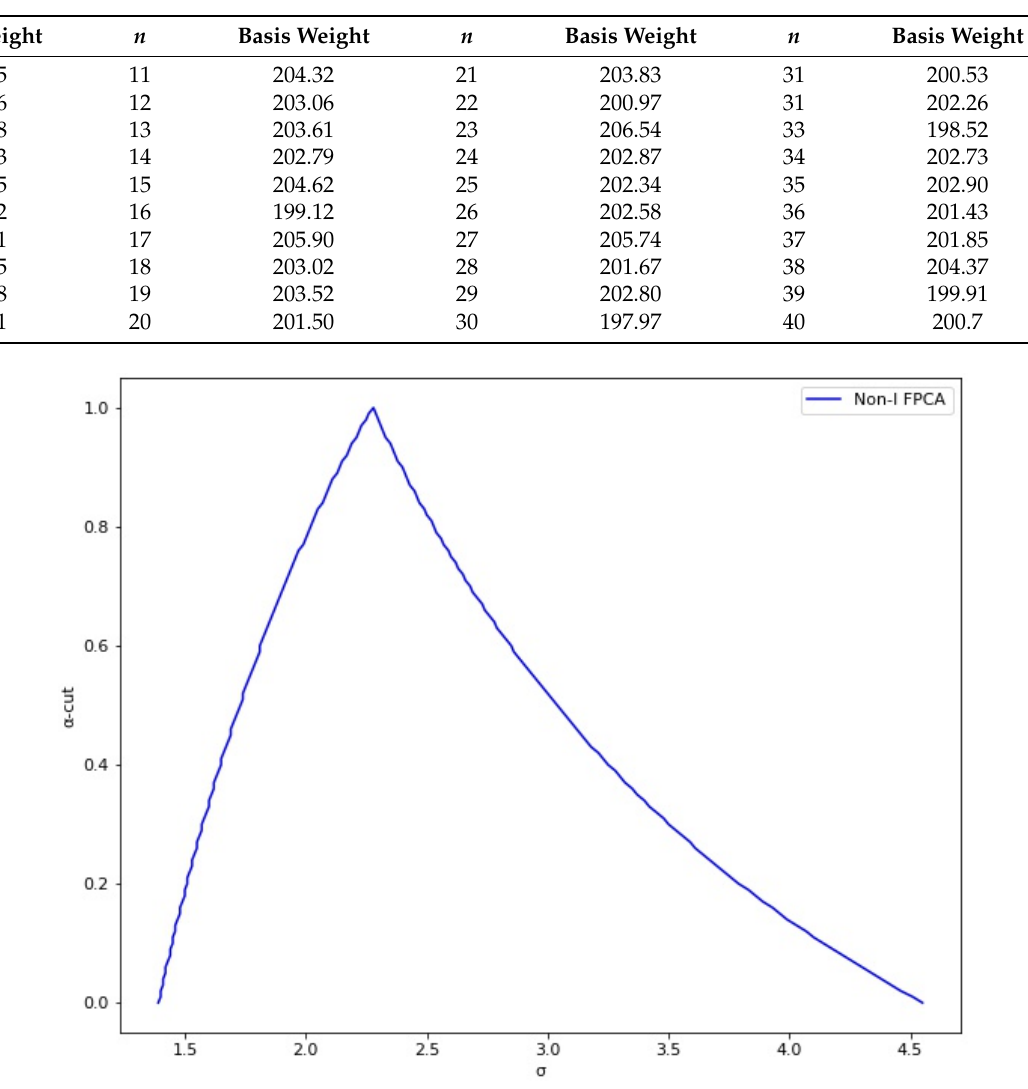
Table 5. Predicted basis weight values (grams) to estimate the variability range.